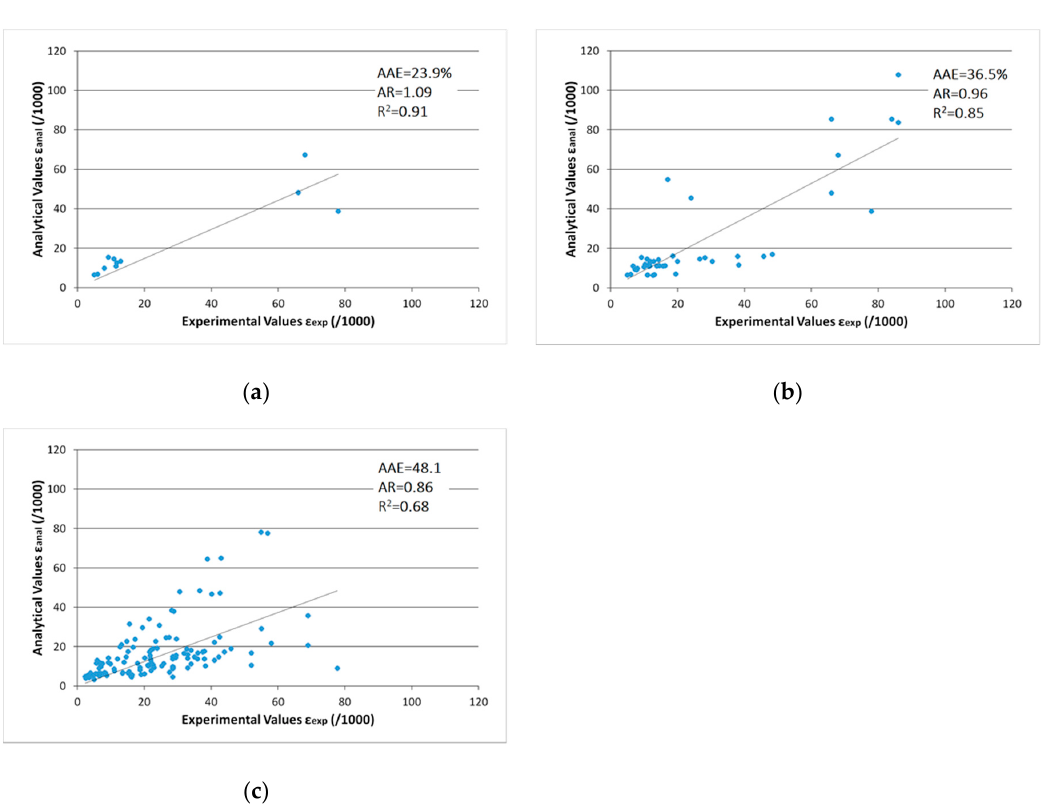
Figure 3. Analytical versus experimental ultimate axial strain for the proposed model ( a ) for the 11 columns analyzed with 3D FE; ( b ) for the total of 44 columns under cyclic axial loading; and ( c ) for the total of 130 columns under monotonic axial loading. the total of 130 columns under monotonic axial